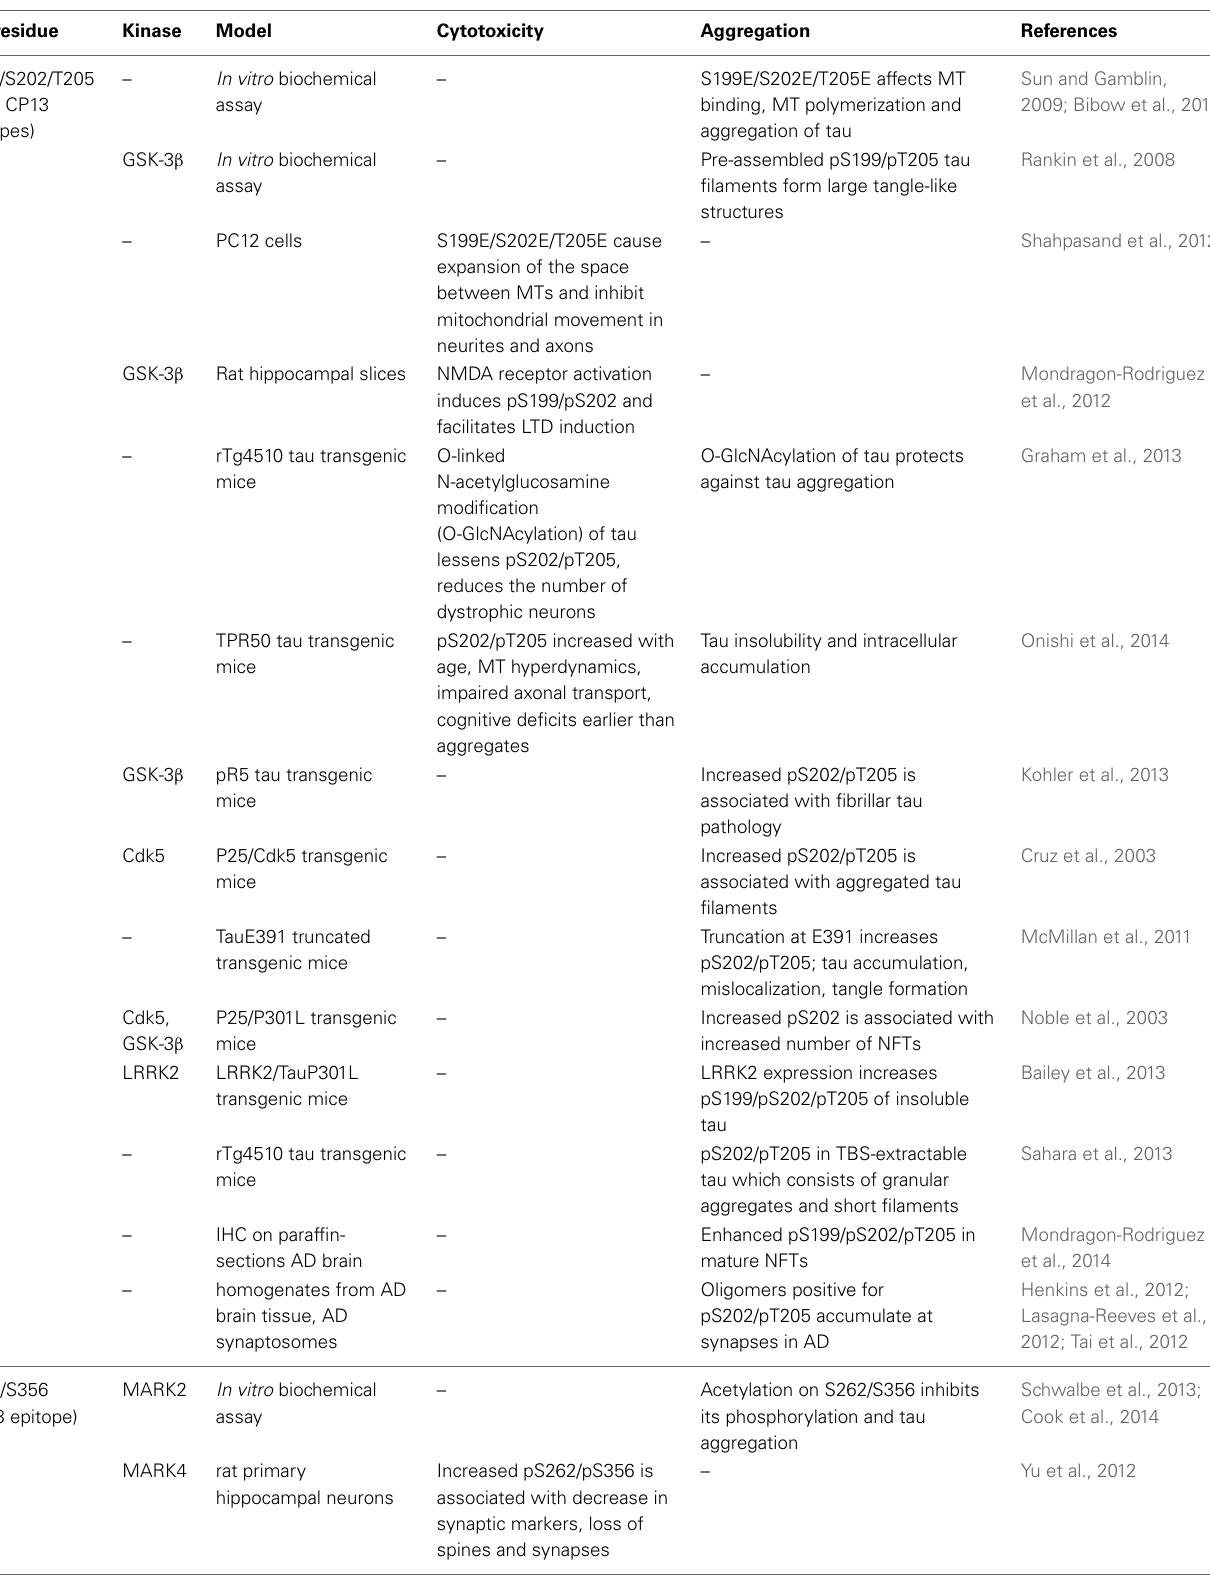
Table 2 | Tau phosphorylation sites and effects. Tau